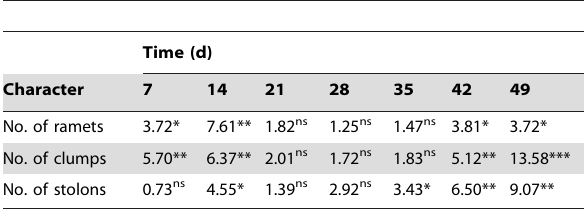
Table 1. Analysis of variance results of Buchloe dactyloides growth characters in different nutrient treatments on different days at genet